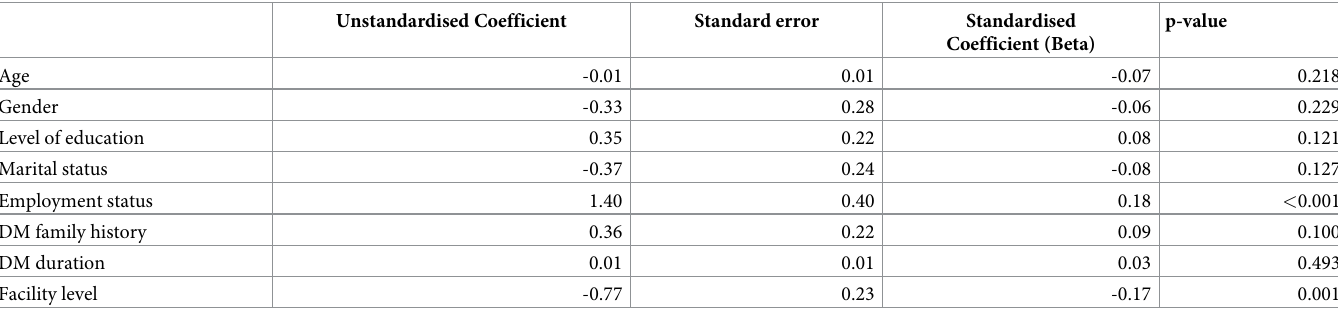
Table 4. Ordinary least squares regression showing relationship between patients’ characteristics and diabetes